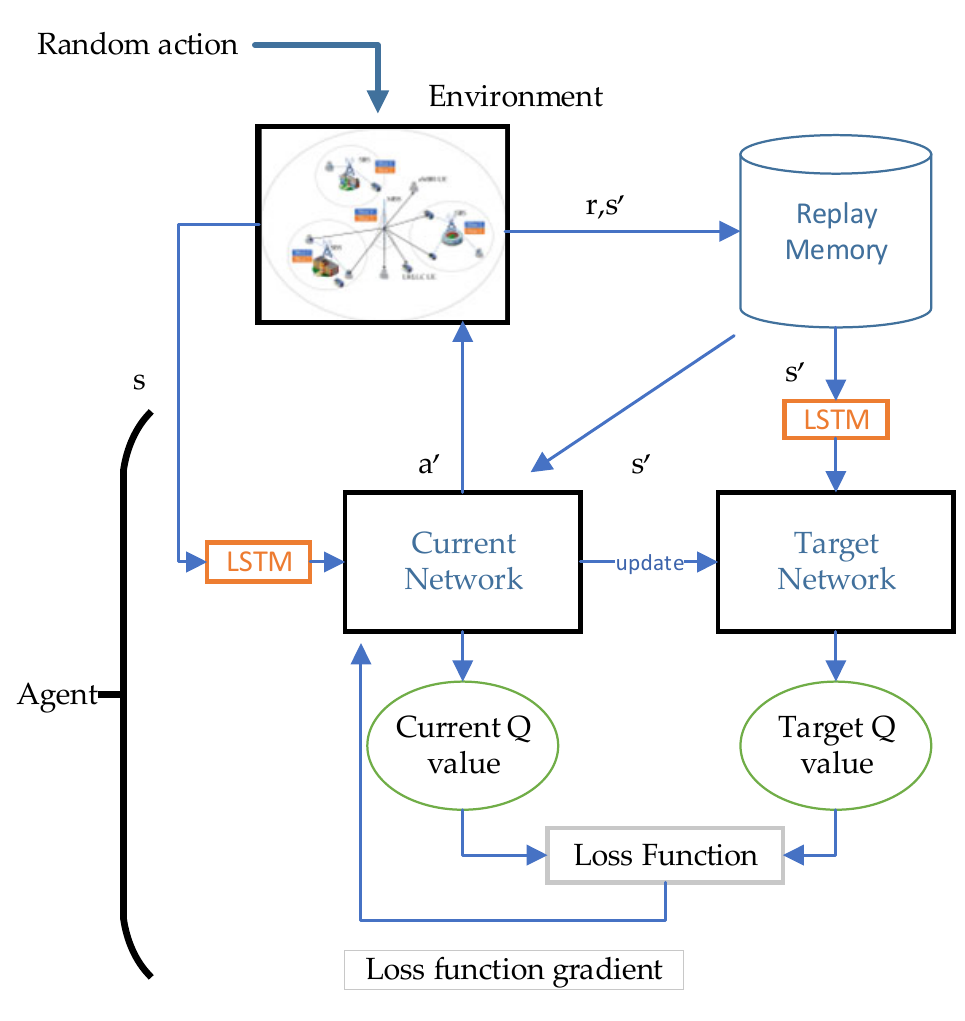
Figure 2. The algorithm flowchart. Algorithm 1 The network slicing resource allocation based on LSTM ‐ D3QN with DC.